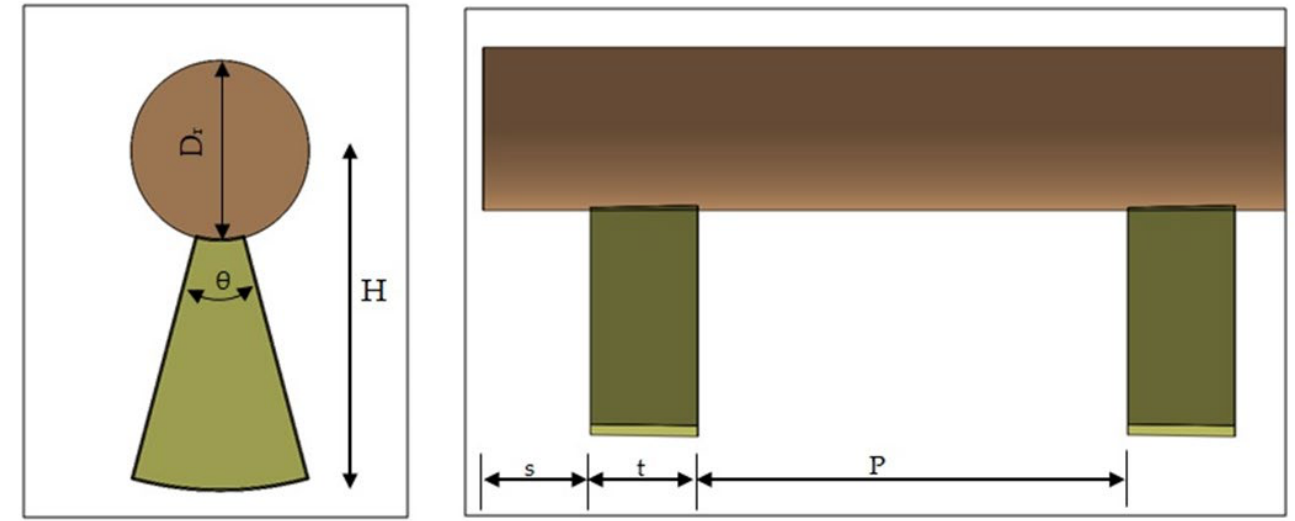
Figure 3. The conical strip geometery examined in the current study. The conical angle varied, at 15 ◦ , 20 ◦ , 25 ◦ and 30 ◦ , whereas the strip height